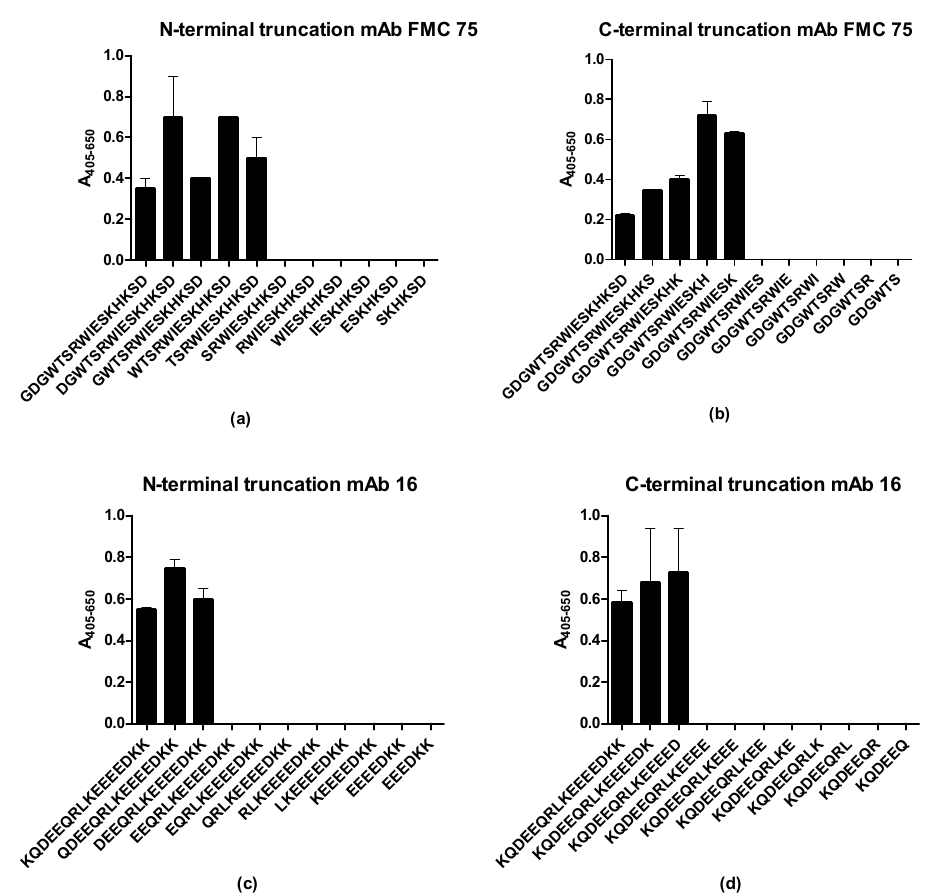
Figure 3. Antibody reactivity to N- and C-terminally truncated peptides. ( a ) Reactivity of mAb FMC 75 to N-terminal truncated peptides. ( b ) Reactivity of mAb FMC 75 to C-terminal truncated peptides. ( c ) Reactivity of mAb 16 to N-terminal truncated peptides. ( d ) Reactivity of mAb 16 to C-terminal truncated peptides.